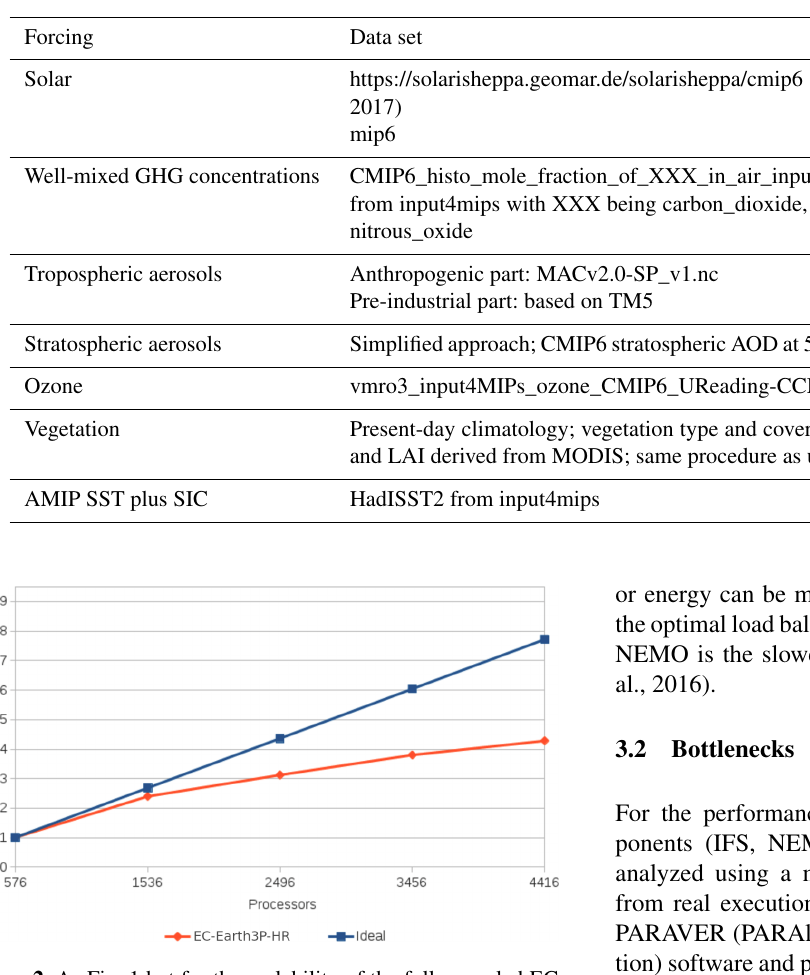
Figure 2. As Fig. 1 but for the scalability of the fully coupled EC- Earth3P-HR. The blue diagonal indicates perfect